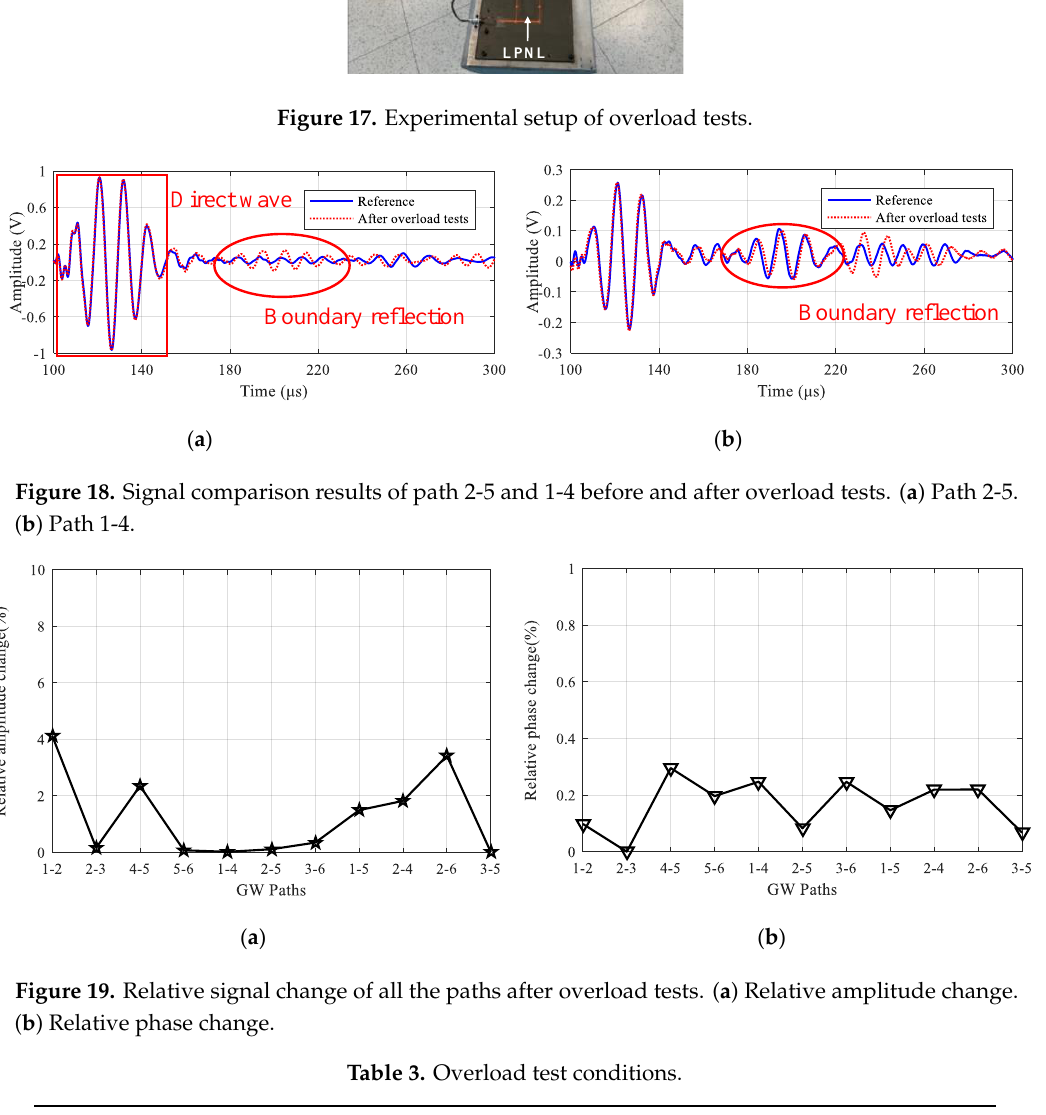
Figure 17. Experimental setup of overload tests. Table 3. Overload test conditions.